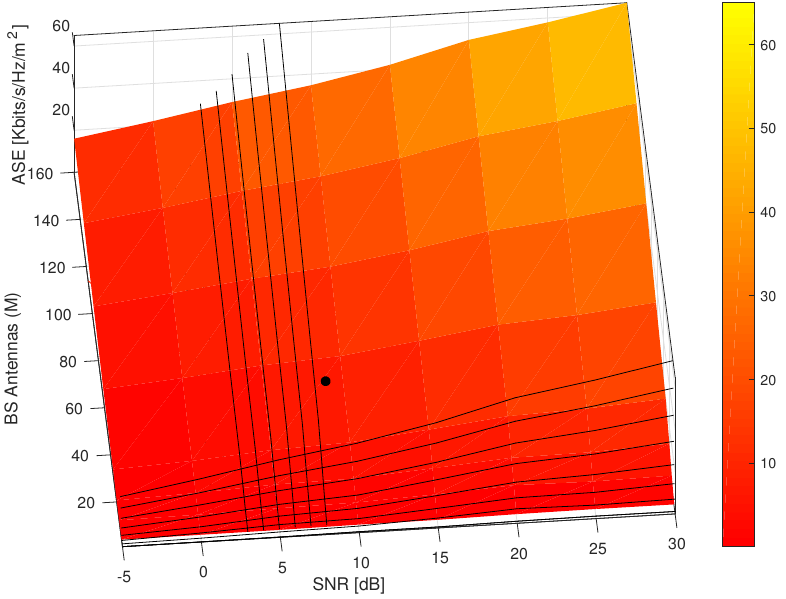
Figure 11. Performance of the ASE versus BS antenna ( M ) and SNR [dB]. Finally, the probability of outage with the SNR p k / σ 2 for various cases of QoS is plotted in Figure 12. Based on the optimization problem (25), a lower QoS value means the small β k factor and lower power p k ensures a low SIR ϕ k . Thus the user is located at the cell-edge of the macro cell and prone to outage. In contrast, the higher QoS values corresponds to large β k factor and high power, with the user located at the cell center. Since all the QoS cases almost approach convergence it indicates cell-edge effect. Also with low power at MBS, cell-center users are better served than cell-edge users, this is practically